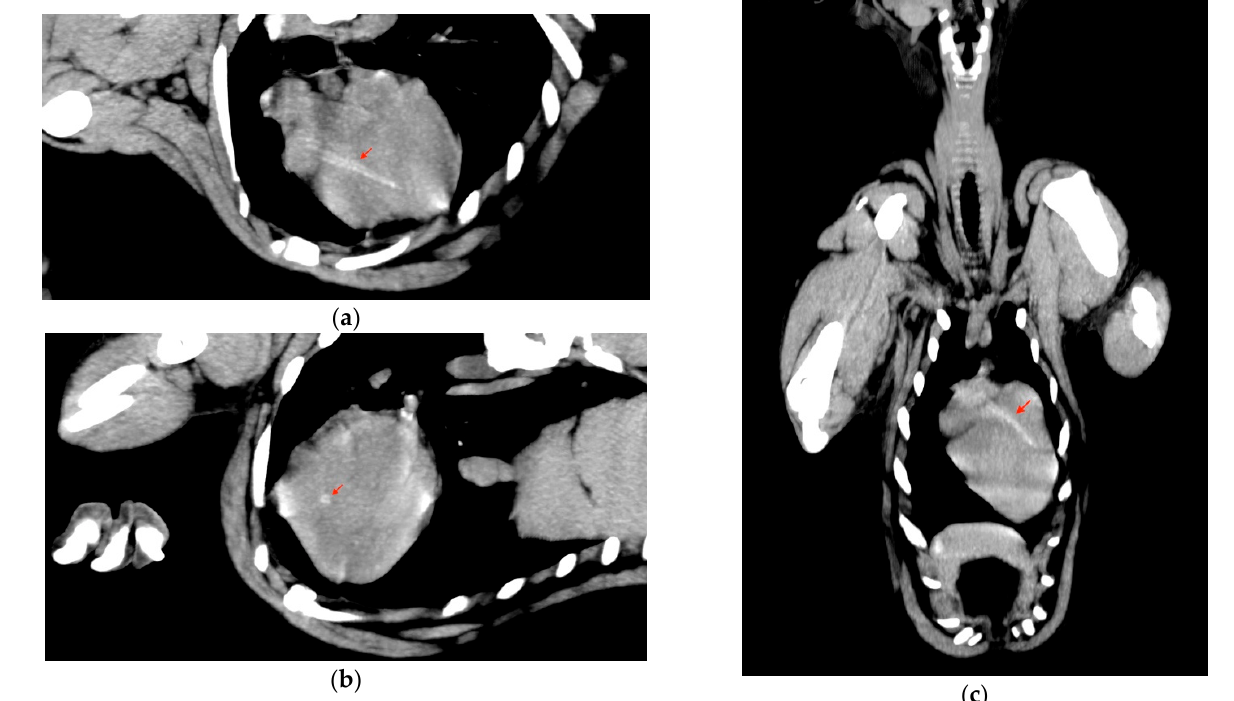
Figure 3. CT multiplanar reconstructions of the cardiac area consent to define the elongated and acuminate shape of a mildly hyperdense intracardiac foreign body (red arrow). ( a ) Oblique cardiac reconstruction shows the length of the foreign body and its tip nearby the external surface of the cardiac wall. The tri-layered aspect allows us to hypothesize the presence of a medullary-like cavity that is confirmed in a para-axial view ( b ) in which is a ring-like structure is visible. ( c ) Dorsal reconstruction allows for the localization of the foreign body in the thickness of the intraventricular septum for most of its length.